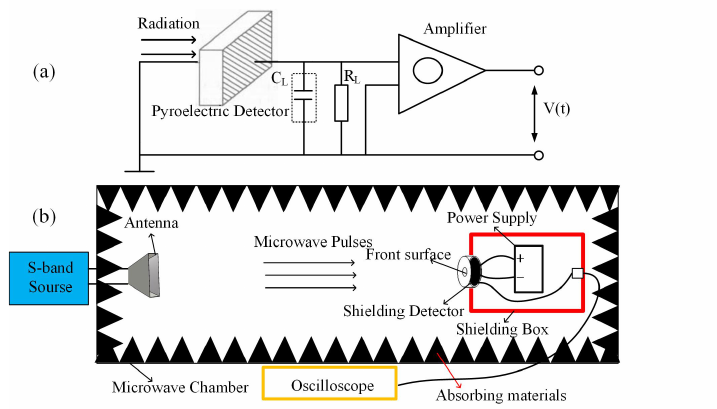
Figure 1. ( a ) signal readout circuit and ( b ) the schematic diagram of the experimental setup. Detailed explanation of it is available in the